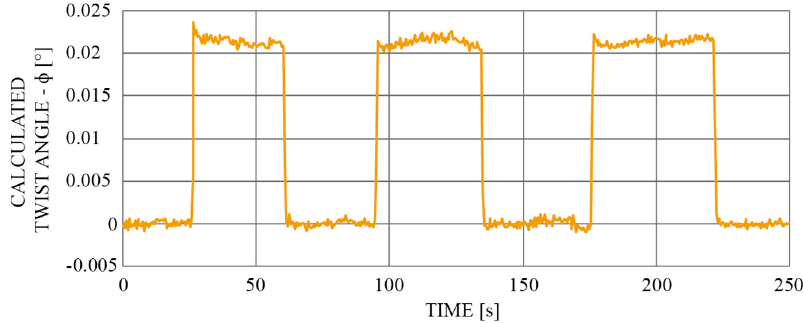
Figure 9. Demonstration of the sensor’s sensitivity: Left and right movement of the rotational stage by 0.02 degrees (mechanical).